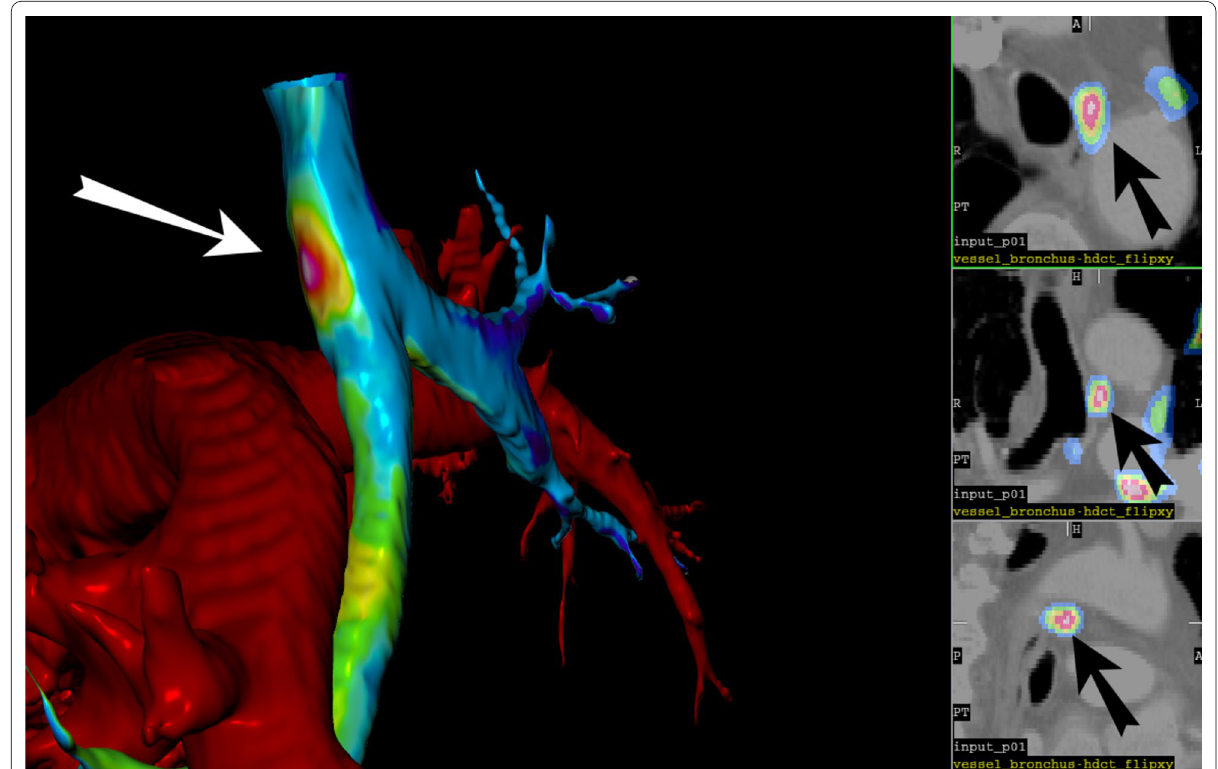
Fig. 4 Visualisation of the airway tree and blood vessels from the outside (left) and orthogonal sections in the vicinity of the lesion indicated by the arrow (right). The projected FDG accumulation in the lesion is displayed in spectral